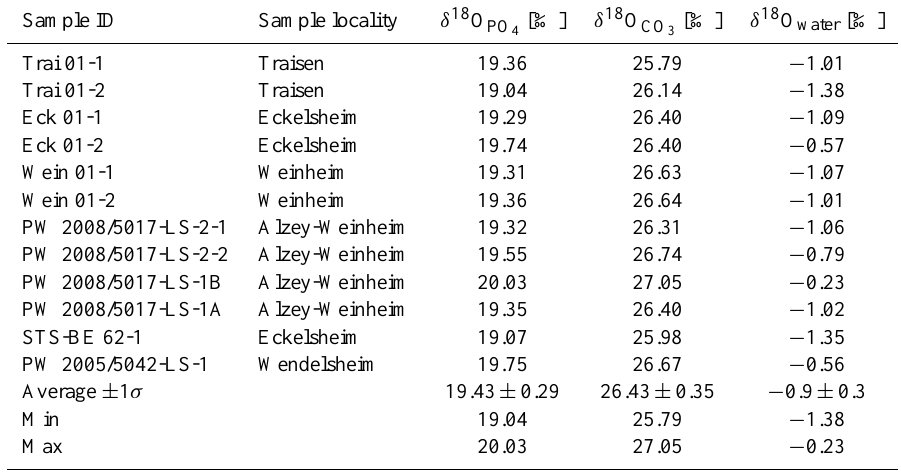
values (VSMOW) of the sea cow teeth from the Alzey formation deposits of the Mainz Basin and and δ 18 O CO Table 1. Enamel δ 18 O PO 3 4 δ 18 O water values calculated from the sea cow enamel δ 18 O PO values. See text for 4